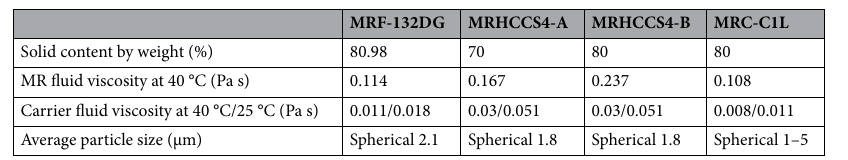
Table 1. MR fluid